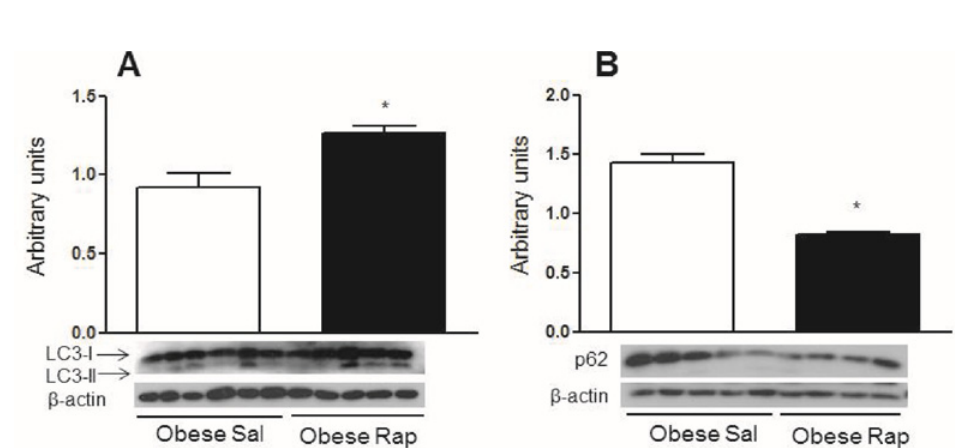
Fig 6. Rapamycin treatment reverses the autophagic downregulation in obese mice. A. Western blotting showing LC3-II to β -actin ratio in the hypothalamus of diet induced obese mice (16 weeks on a HFD) treated (once per day) for 5 days with 2 μ l of a solution that contained 25 μ M rapamycin (Rap) or saline (Sal). B. The p62 content in the hypothalamus of the diet induced obese mice treated with rapamycin. Values are shown as mean ± SEM. * P < 0.05; n = 5 – 6 animals per group.